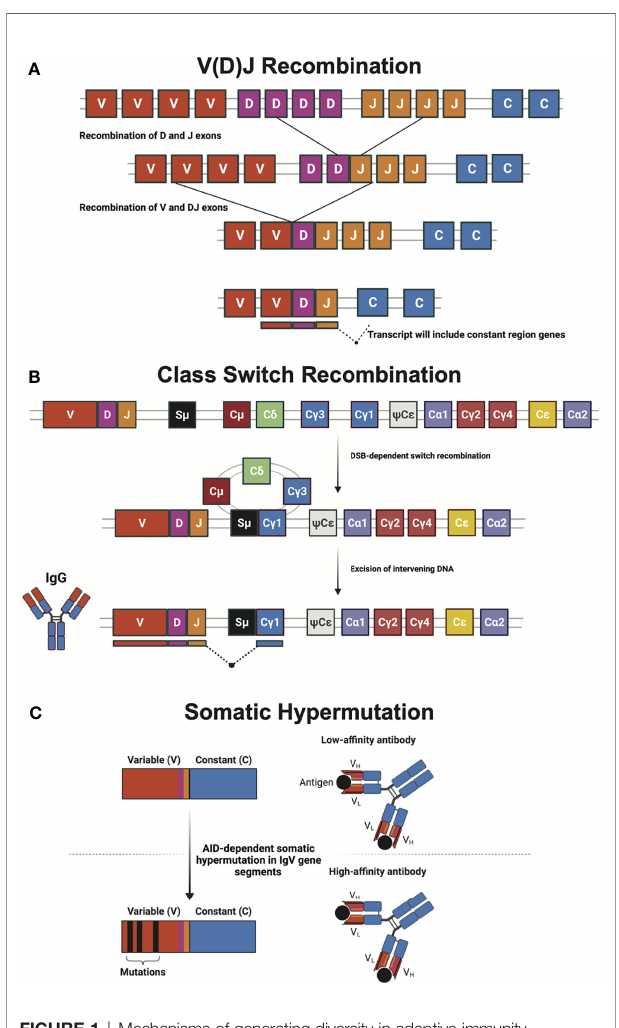
FIGURE 1 | Mechanisms of generating diversity in adaptive immunity. (A) V(D)J recombination relies upon RAG-mediated recombination for the rearrangement of immunoglobulin and T cell receptor variable (V), diversity (D), and joining (J) gene segments during lymphocyte development. Many enzymes involved in non-homologous end joining (NHEJ) and other DNA repair mechanisms are required to correct the programmed DNA double-strand breaks (DSB) that initiate gene segment rearrangement. (B) Class-switch recombination (CSR) of the immunoglobulin heavy chain locus swaps antibody isotype via recombination of different constant (C) regions. CSR requires activation-induced cytidine deaminase (AID) to initiate a DNA DSB break at the switch (S) region, which is subsequently repaired by classical and alternative NHEJ. The schematic shows a CSR event that leads to the production of IgG antibody isotype. (C) Somatic hypermutation (SHM) utilizes AID-dependent programmed mutations in the variable region of antibody gene segments to create a large number of antibodies with goal of creating greater af fi nity for antigen. Antibody heavy (V H ) and light (V L ) chains, as well as antigen (black circle) are illustrated. Figure created with